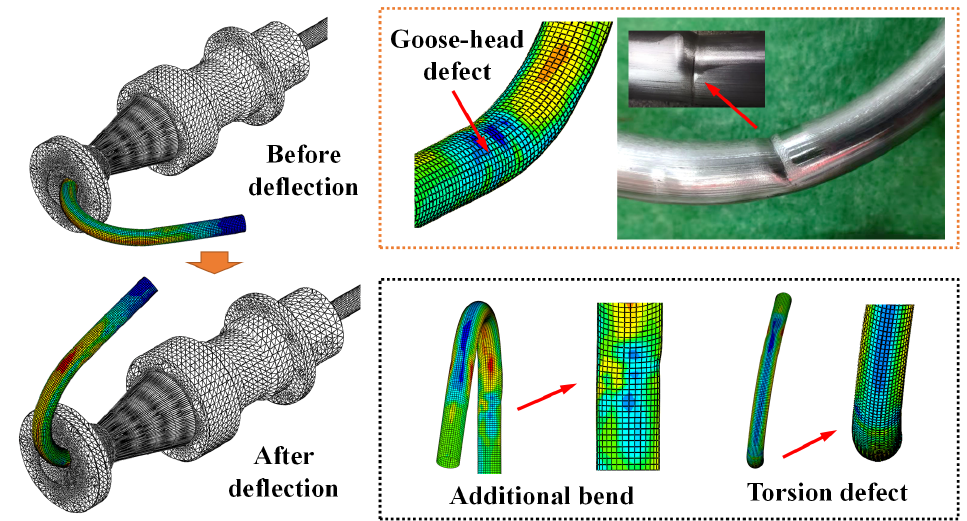
Figure 8. Defects caused by active deflection.